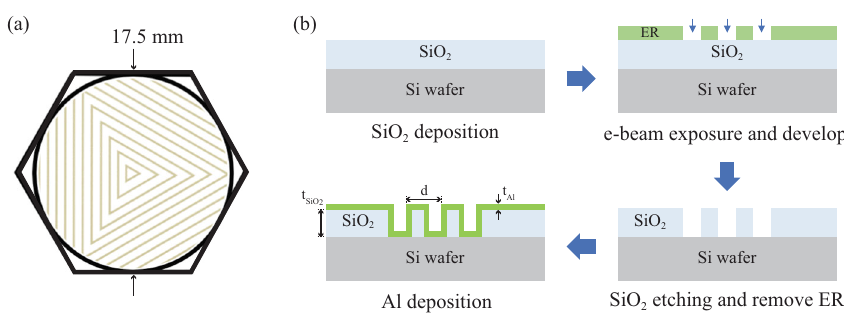
Fig. 9 Grating design and fabrication process. a Schematic of the hexagonal grating chip showing a side-to-side length of 17.5 mm and three grating areas symmetrically arranged in the circular shape. The non-grating fl at edges are used for the grating retainer clips. The 1/ e 2 beam diameter of the cooling beam is 28 mm truncated to ≈ 19 mm by the fused silica viewport. b Fabrication process of the GMOT grating chip. Parameters for the grating chip used in this = 195 nm, d = 1.2 μ m, and ~ 50% duty cycle (details in main text). paper are t Al = 50nm, t SiO 2